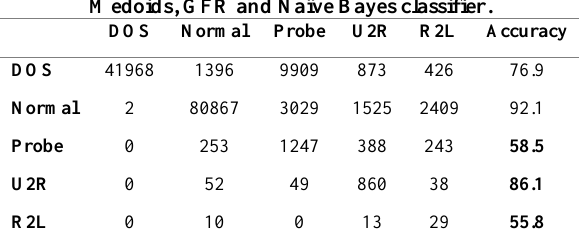
Table 4. Confusion matrix obtained by utilizing K- Medoids, GFR and Naïve Bayes